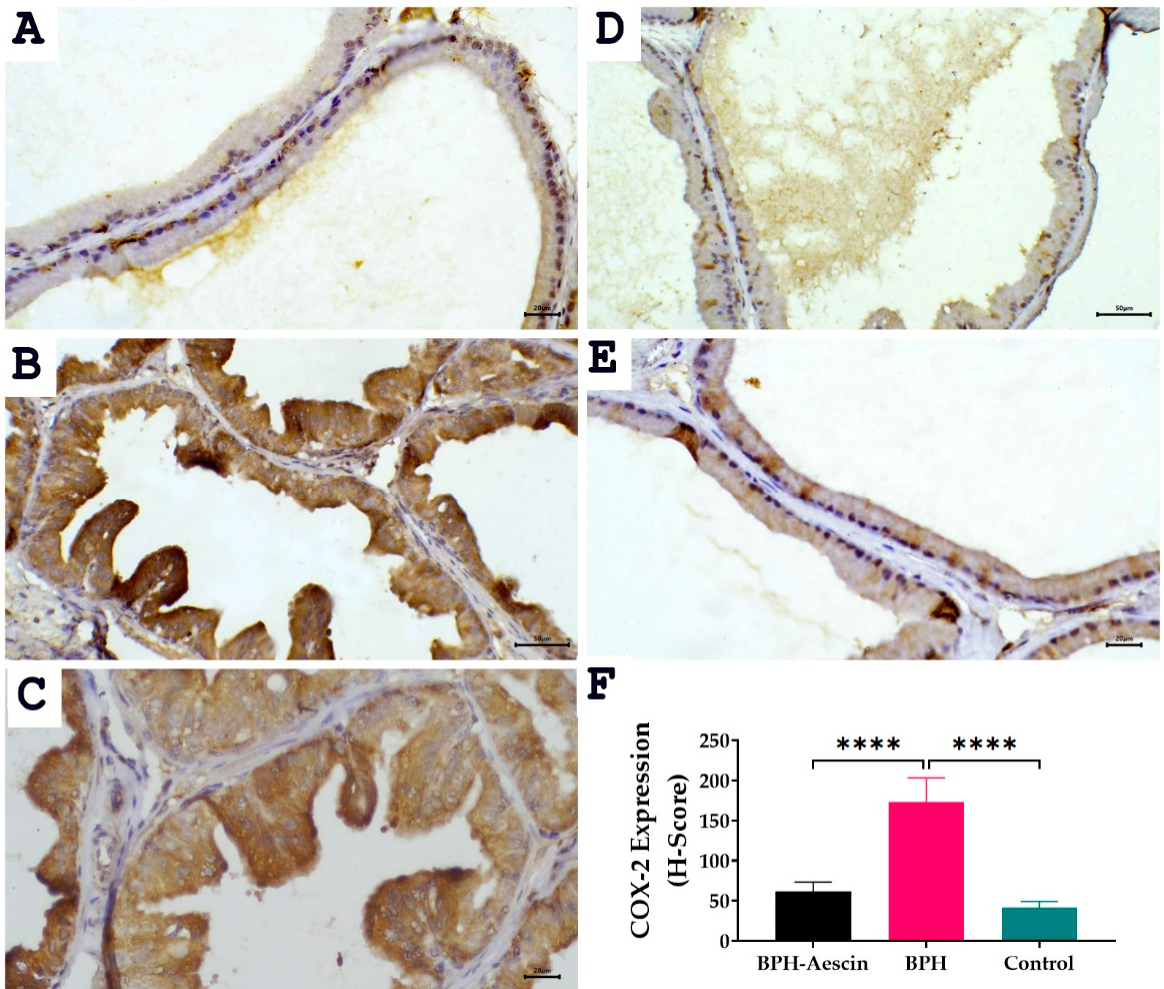
Figure 7 . Effect of aescin treatment on the expression of prostate COX-2. The representative photomicrographs show the immunohistochemical staining of COX-2 in the prostate tissues among various studied groups. ( A ): Normal prostate tissue showing faint COX-2 staining (400×). Prostate tissue of the BPH group shows diffuse marked increase in cytoplasmic COX-2 immuno-expression (( B ), 200× and ( C ), 400×). The prostatic tissue from animal groups treated with aescin shows a marked decrease in COX-2 immuno-expression (( D ), 200× and ( E ), 400×). The bar graph ( F ) shows semi-quantitative analysis of COX-2 expression in the rat prostates among the different studied groups expressed as H-score values as described in Section 4 Materials and Methods. A significant elevation in COX-2 expression was observed within prostatic acini in the BPH group compared with either the normal control or the aescin-treated BPH groups. Data in the bar chart (mean ± SEM of 5 tissues) were analyzed by one-way ANOVA followed by Tukey’s multiple comparisons test. **** denote significant differences between the selected groups at p < 0.0001.